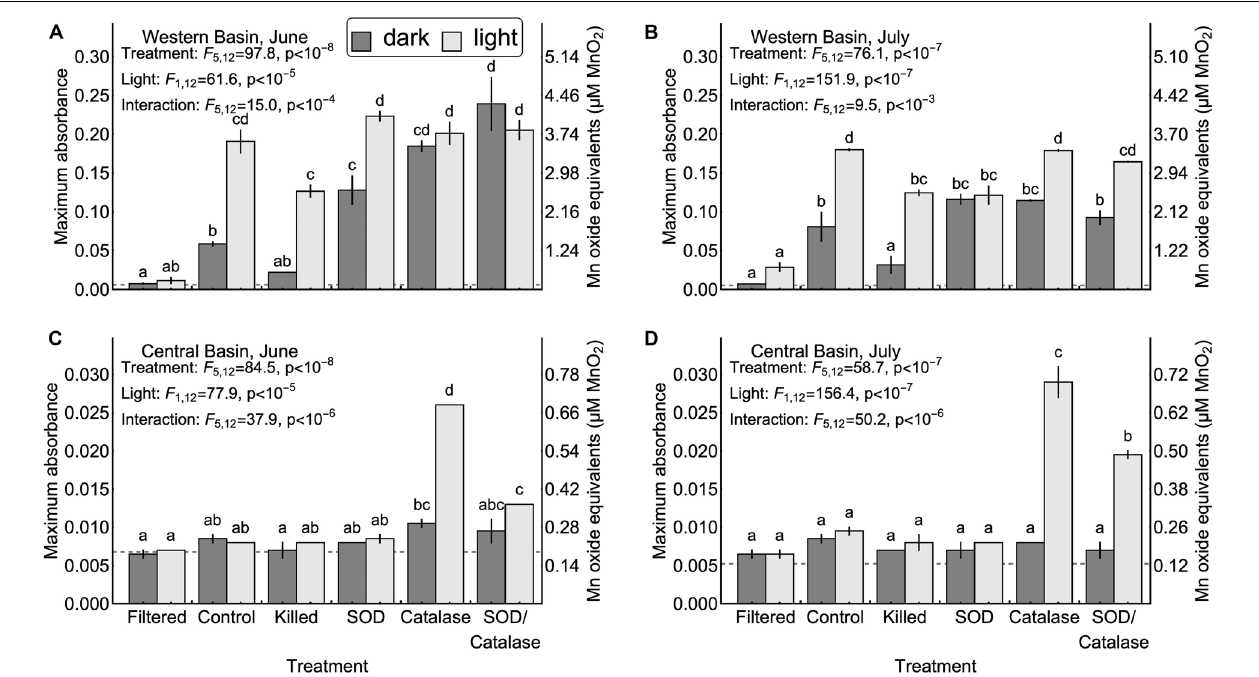
FIGURE 2 | Maximum Mn oxide concentrations observed in each experiment. Error bars represent the values measured in two experimental replicates. Upper confidence intervals for the mean of 10 method blanks are denoted by dash gray lines. Note that the vertical axis ranges differ between the central basin (A,B) and western basin (C,D) . Inset letters denote groups of treatments that were not significantly different based on post-hoc comparisons ( p < 0.05). Any two treatments that do not share one letter in common are interpreted as different by this